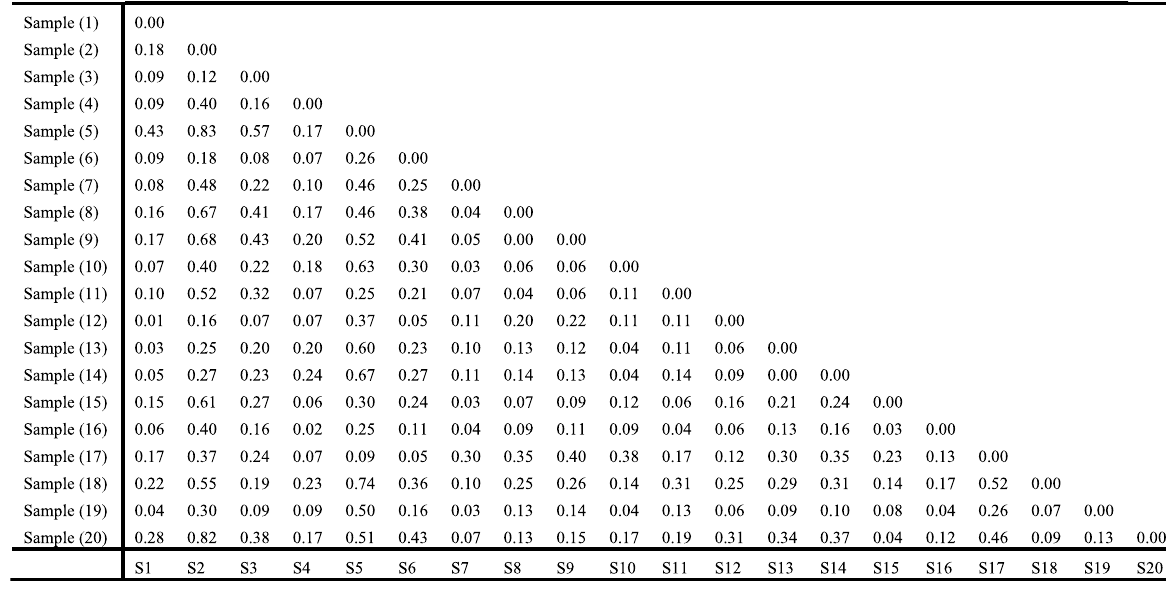
Table 4 Estimates of base composition bias difference between